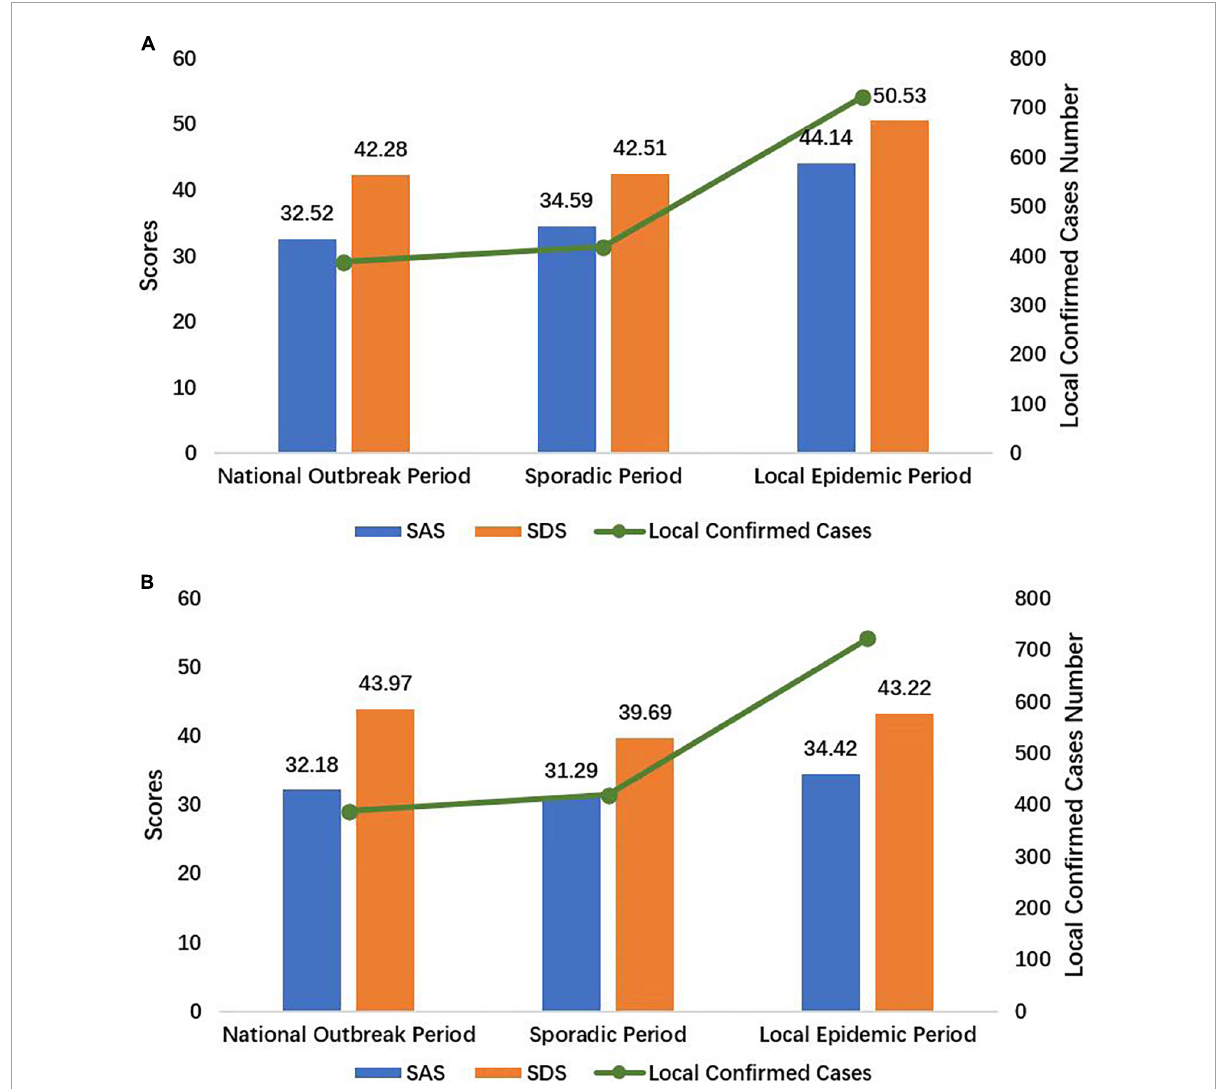
FIGURE3 The SAS and SDS scores of FHWs (A) and SIPs (B) during the national outbreak, sporadic and local epidemic periods. SAS , the Zung Self-Rating Anxiety Scale; SDS , the Zung Self-Rating Depression Scale; FHWs, frontline health care workers; SIPs, suspected infected